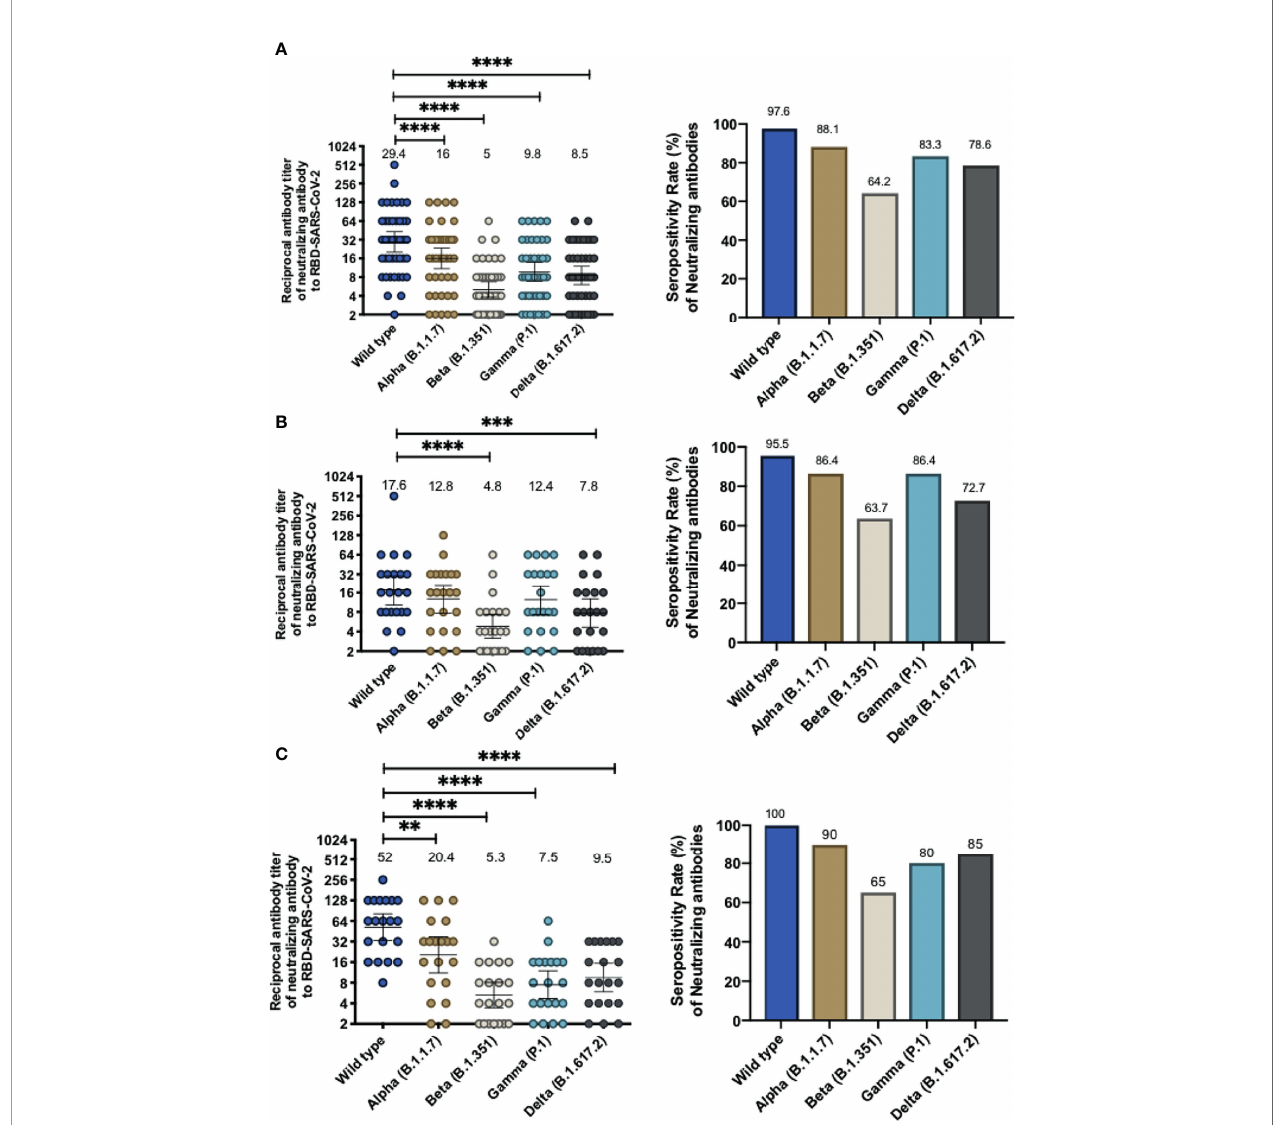
FIGURE 1 | Immunization with CoronaVac induces antibodies able to inhibit the interaction between hACE2 and S1-RBD from SARS-CoV-2 variants after two immunizations in a 0-14 and 0-28 schedule. Antibody titers were evaluated with a surrogate virus neutralization assay (sVNT), which quanti fi es the interaction between S1-RBD from either WT SARS-CoV-2 or variants of concern (Alpha, Beta, Gamma, and Delta) and hACE2 on ELISA plates. Total neutralizing antibodies titer from volunteers vaccinated with CoronaVac, 28 days after the second dose and the seropositivity rate of neutralizing antibodies are shown for both vaccination schedules (A) , 0-14 schedule (B) and 0-28 schedule (C) . Numbers above the bars show the Geometric Mean Titer (GMT), and the error bars indicate the 95% CI in the graphs showing total antibody titers, and the number above bars show the percentage of seropositivity rate in the respective graphs. A Wilcoxon test analyzed data to compare against the wild-type RBD; **p < 0.005, ***p < 0.001, ****p < 0.0001. The graph represents the results obtained for 22 volunteers for the 0-14 schedule and 20 volunteers for the 0-28